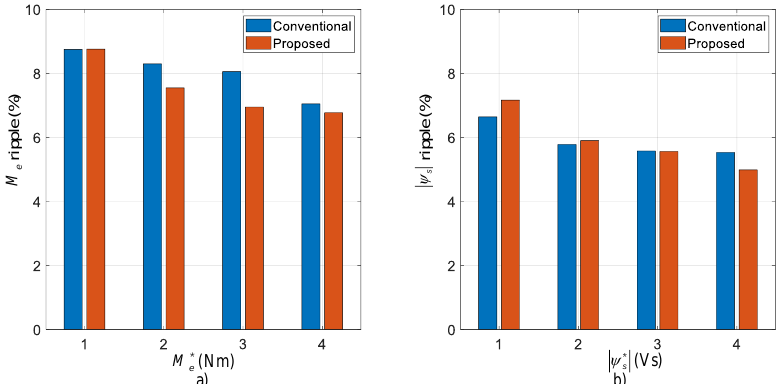
Figure 6. Steady state experimental evaluation of the conventional and the proposed deadbeat control. ( a ) Electromagnetic torque ripple percentage. ( b ) Stator flux ripple percentage.